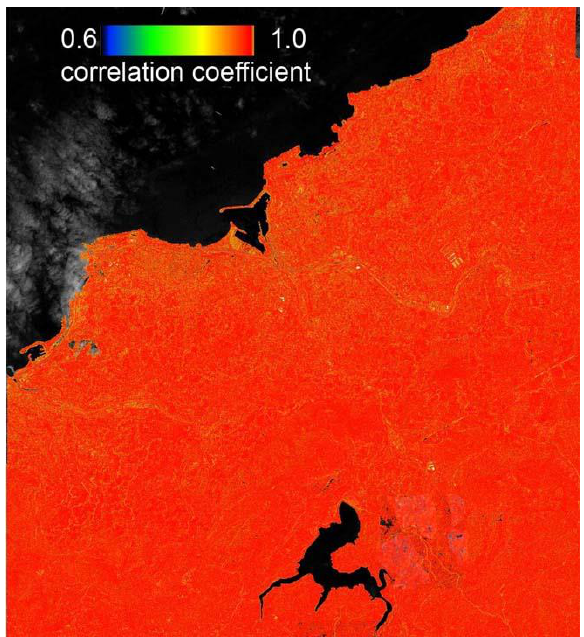
Figure 12. Distribution of correlation coefficients for Pleiades model with base to height relation 1:4.5